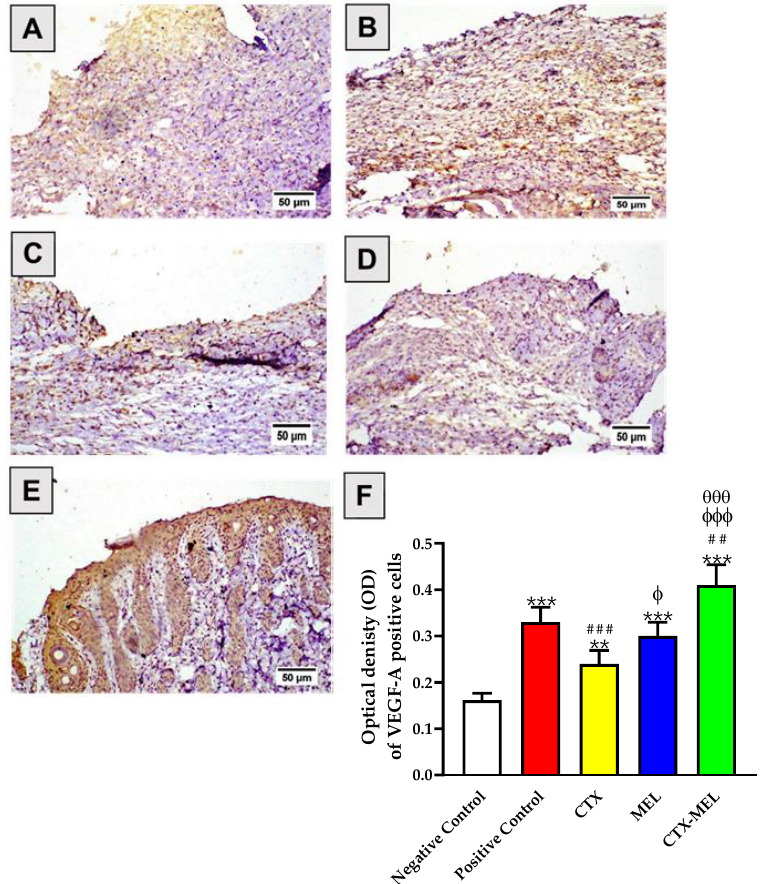
Figure 7. Immunohistochemical assessment of VEGF-A expression in skin tissues obtained from diabetic rats belonging to the different experimental groups. ( A ) Negative control, ( B ) positive control, ( C ) CTX, ( D ) melittin, (E) CTX – MEL, ( F ) quantitative representation of VEGF-A expression. Negative control refers to rats that received topical plain vehicle consisting of HPMC-based hydrogel (1.5% w / v ) on the wound area, while positive control refers to animals that received 0.5 g of Mebo TM ointment on the wound area. Data are expressed as mean ± SD, ( n = 6). ** Significantly different vs. negative control, p < 0.01; *** significantly different vs. negative control, p < 0.001; ## significantly different vs. positive control, p < 0.01; ### significantly different vs. positive control, p < 0.001; φ significantly different vs. CTX, p < 0.05; φφφ significantly different vs. CTX, p < 0.001; θθθ significantly different vs. CTX, p <